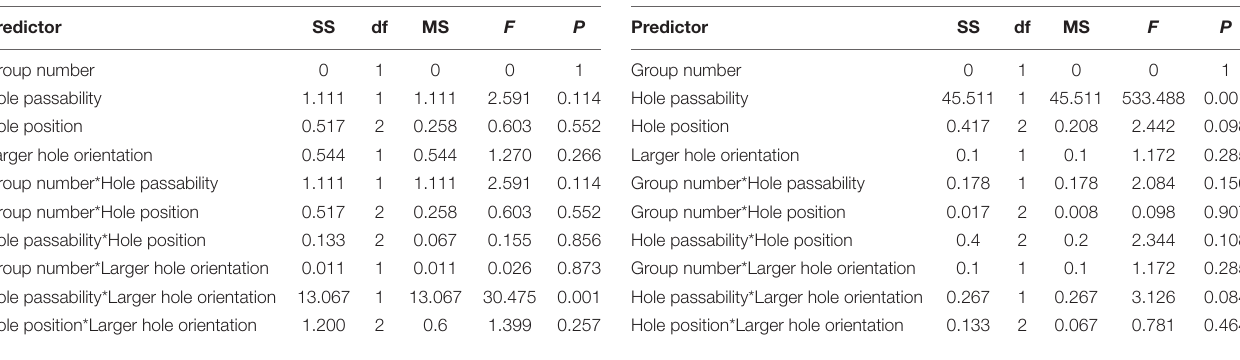
TABLE 2 | Results of the Experiment 2 of 12 test trials: evaluation of the influence of various predictors (group number, passability of the hole, position, orientation of the larger hole) on first approaches in a trial, the factorial ANOVA.